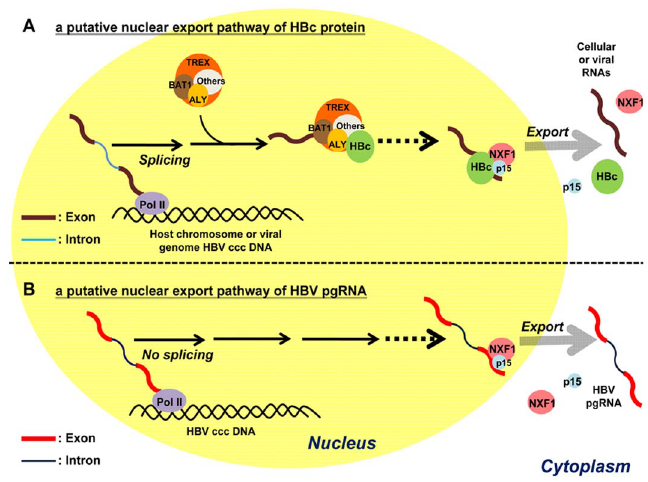
Figure 9. A graphic summary of the nuclear export of HBV pgRNA and HBc. A) A cartoon illustrates a putative nuclear export pathway of HBc protein. HBV DNA genome can exist episomally as a covalently closed circular form (ccc DNA) in the nucleus, which can serve as a template for pol-II mediated RNA transcription [3]. Pre-mRNA processing and nuclear export are known to be tightly coupled by the TREX complex, which consists of ALY, BAT1, and others (other known or unknown cellular factors) [65]. HBc protein can associate with ALY, but not BAT1. Dotted line indicates that the exact sequence or molecular mechanism remains unclear. HBc protein can also associate with NXF1 and p15. It is speculated here that the NXF1- p15 export machinery can recognize a stable RNP complex between HBc protein and RNA of either viral or cellular origins. B) Nuclear export of the 3.5 kb non-spliced pgRNA is dependent on the NXF1-p15 machinery. The exact molecular mechanism of pgRNA export remains to be further investigated in the